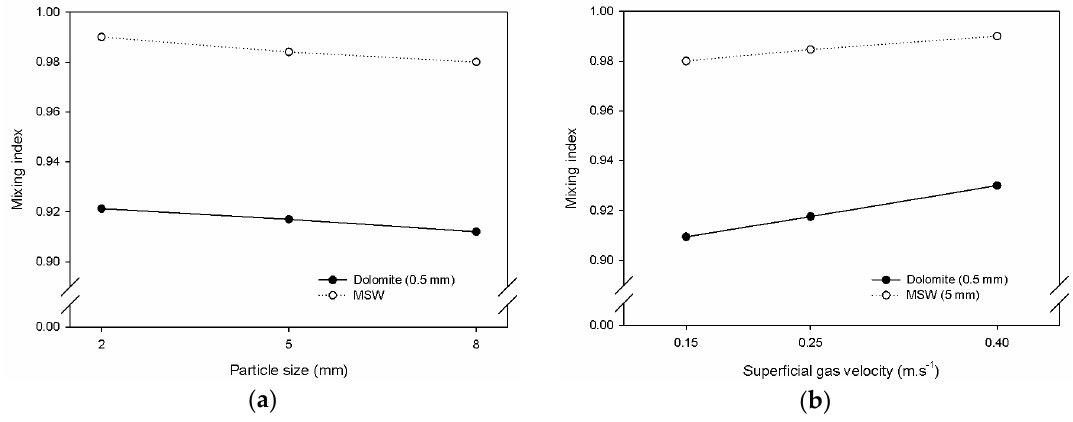
Figure 9. Mixing index study: ( a ) MSW particle size effect on mixing; ( b ) superficial gas velocity effect on mixing.